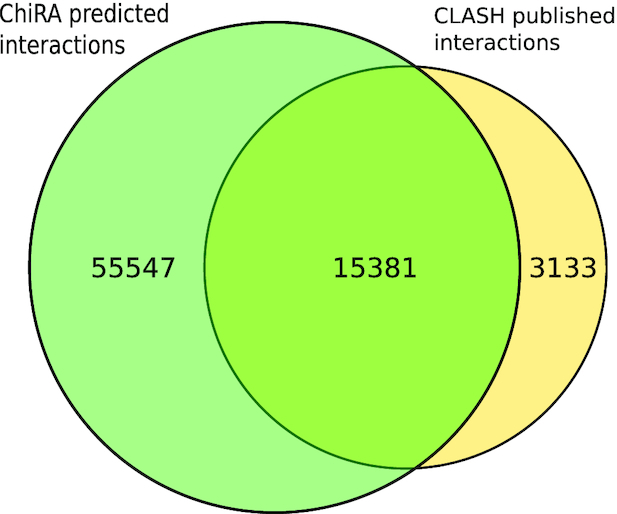
Number of interactions that were detected by ChiRA compared to published interactions in CLASH datasets.